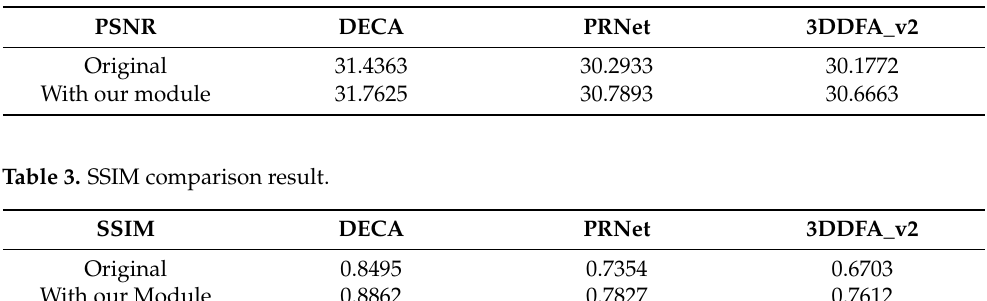
Table 2. PSNR comparison result.